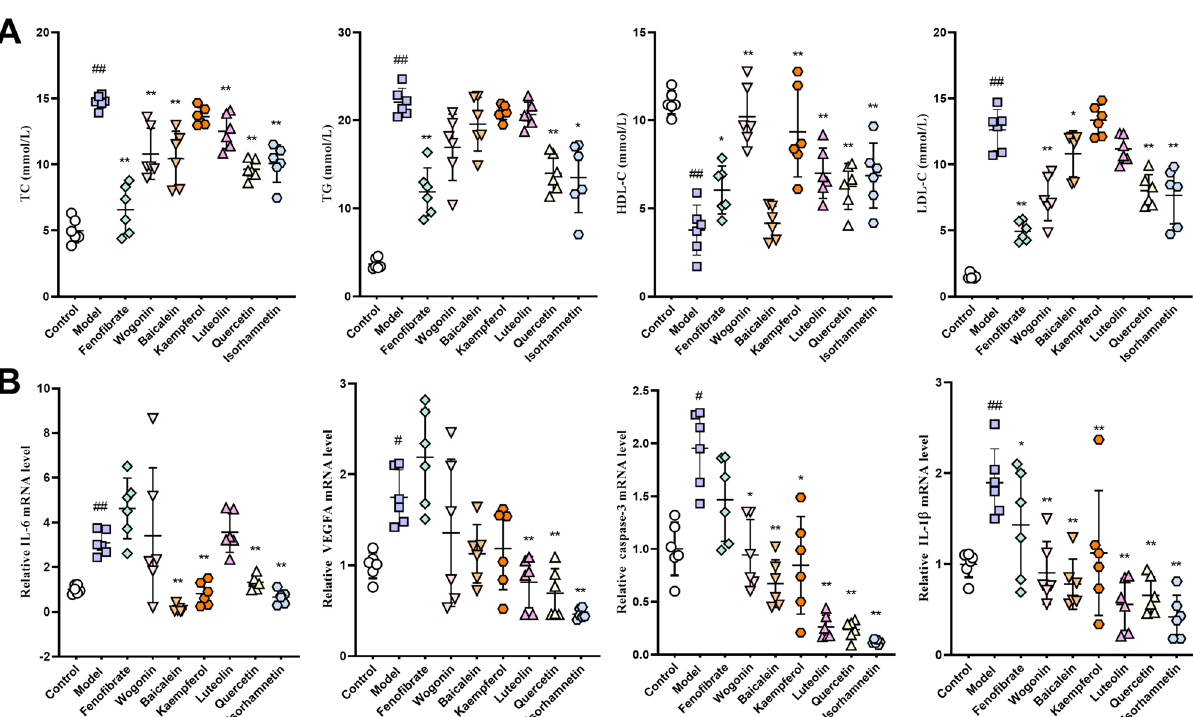
Figure 9. Effect of BSTZC on serum and liver in triton-1339W-induced HLP mice. (A) Biochemical analyses of serum TC, TG, HDL-C and LDL-C. (B) The expression of IL-6, VEGFA, caspase-3 and IL-1β mRNA level. The results are expressed as mean ± standard deviation. (n = 6). # P < 0.05, ## P < 0.01 vs control group; * P < 0.05, ** P < 0.01 vs model